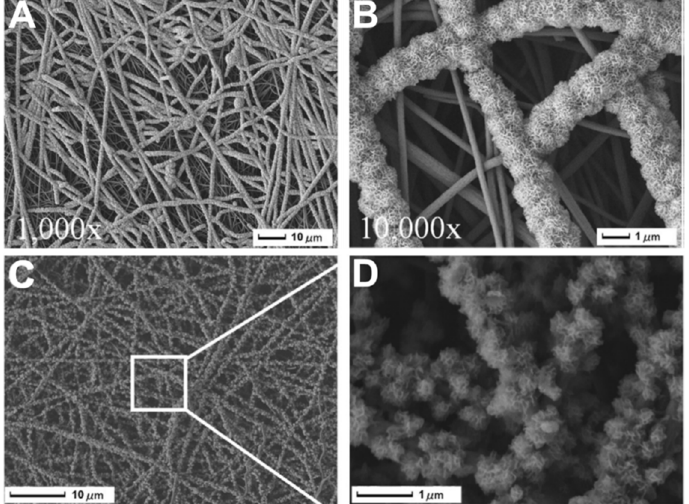
Figure 4. SEM photos show the development of HAp particles on T-CNF mats treated with NaOH aq. solution at concentrations of ( A ) 8%, ( B ) 16%, ( C ) 20%, and ( D ) the crystals that resemble flowers. One day for cultivation. Reproduced with permission from Ref.